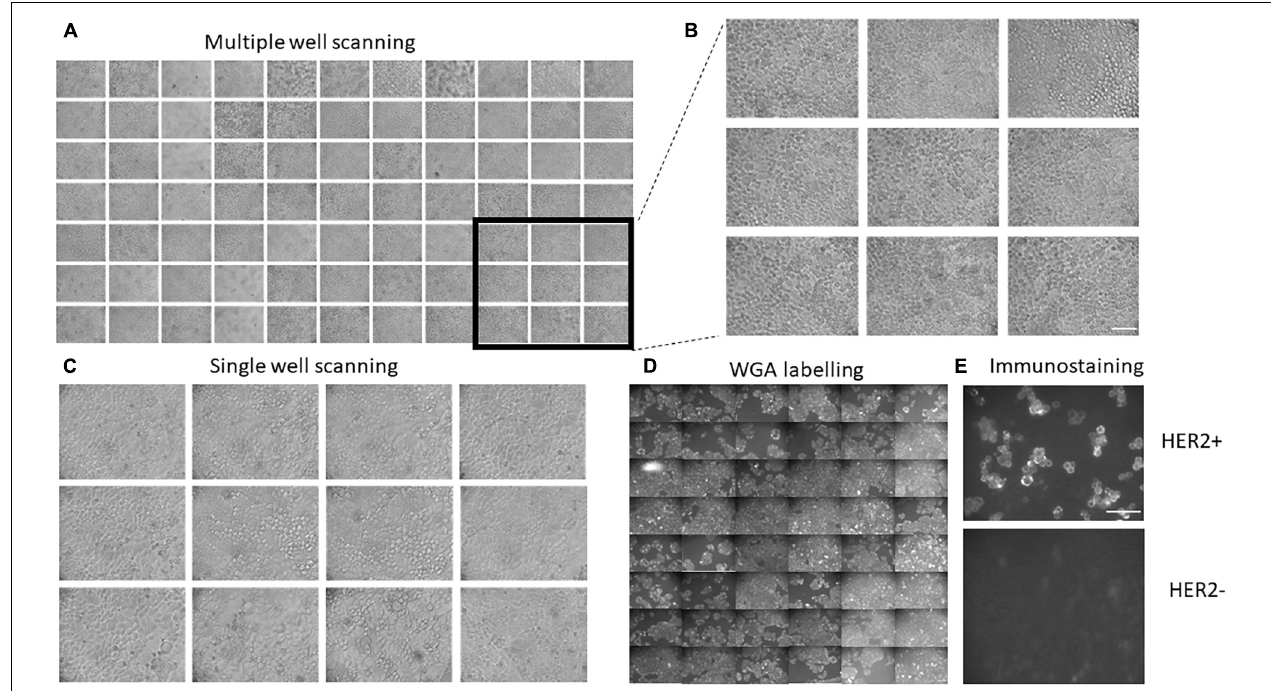
FIGURE 2 | Further examples demonstrating the applicability of the developed platform. (A,B) Generation of a large number of images from multiple wells. (C) Single-well scanning. The XY platform is positioned in the center of a single well and multiple images of images of HeLa cells were taken from the same well. (D) Examples of automatic labeling of HeLa cells with Wheat Germ Agglutinin and subsequent automatic imaging. Panel shows examples of imaging from 48 different wells. Autofocusing was performed in white light. (E) Example of immunostaining experiment using Herceptin as primary antibody and Alexa 488-conjugated antihuman antibody. Strong immunolabeling was observed in SKBR3 cells but not in the HeLa cells that have relatively low levels of the receptor. Scale bars are 100 µ